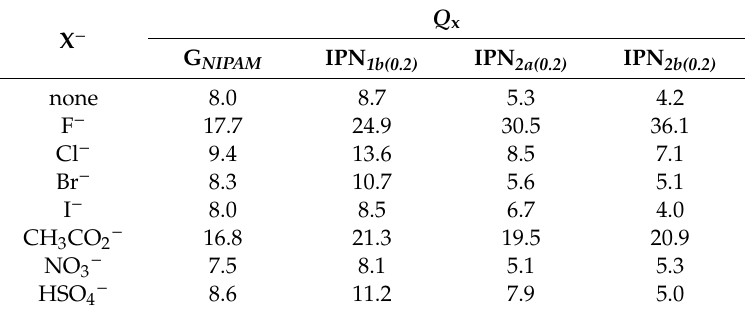
Table 3. Q values estimated for the obtained gels in the absence and presence of tetrabutylammonium salts (TBAX) in DMF.